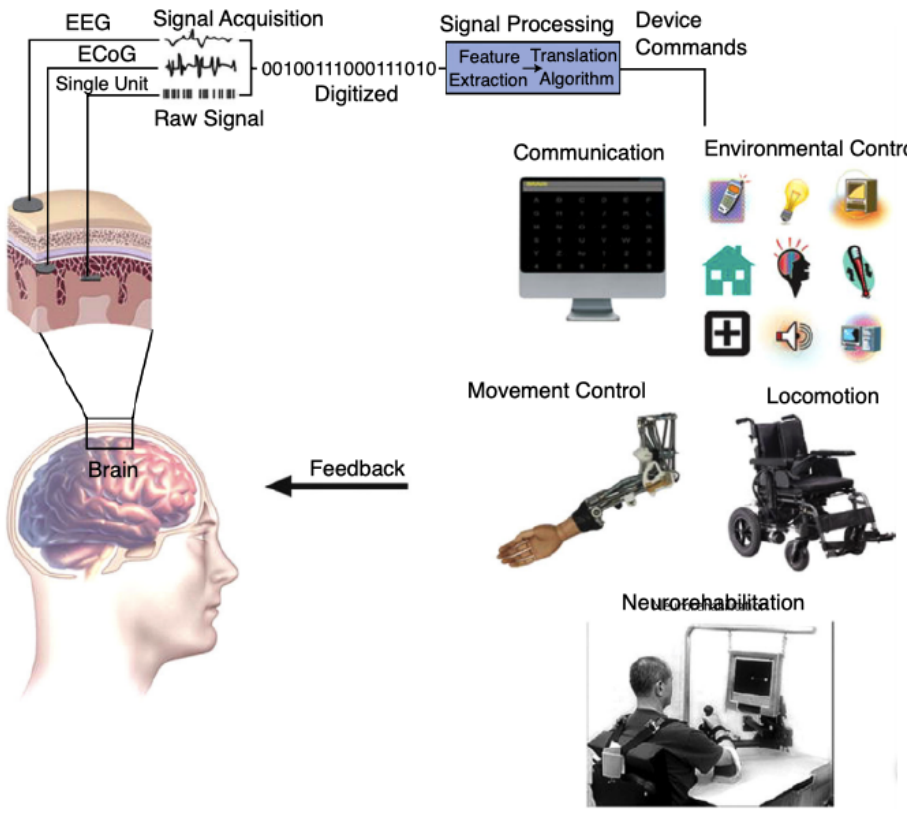
Figure 1. Components of a typical BCI system and its communication methods—simplified